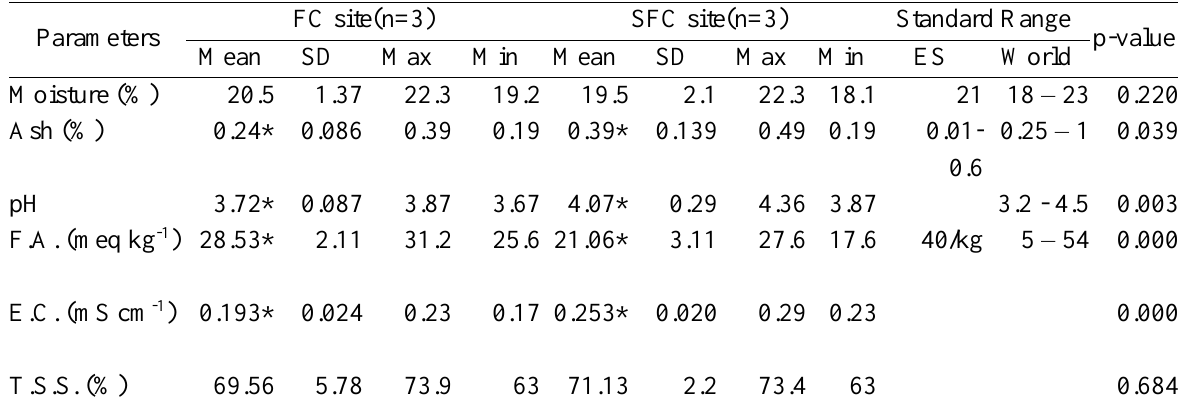
Table 9 Physicochemical characterizations of honey from Gera district (both Forest types) Parameters Moisture